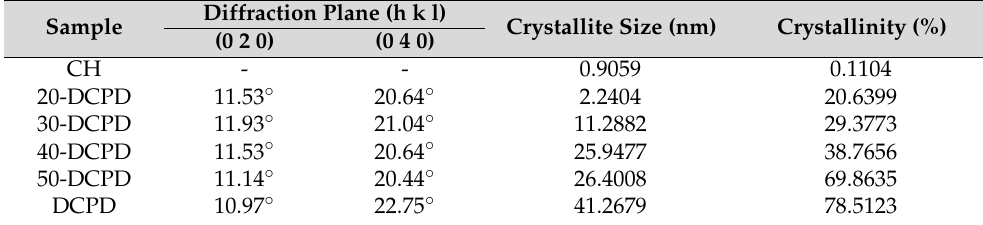
Table 2. Rietveld analysis, Bragg’s law and Scherrer’s equation were utilised to determine diffraction plane indexes, crystallite size and crystallinity of the unloaded and DCPD mineral-loaded freeze-dried chitosan